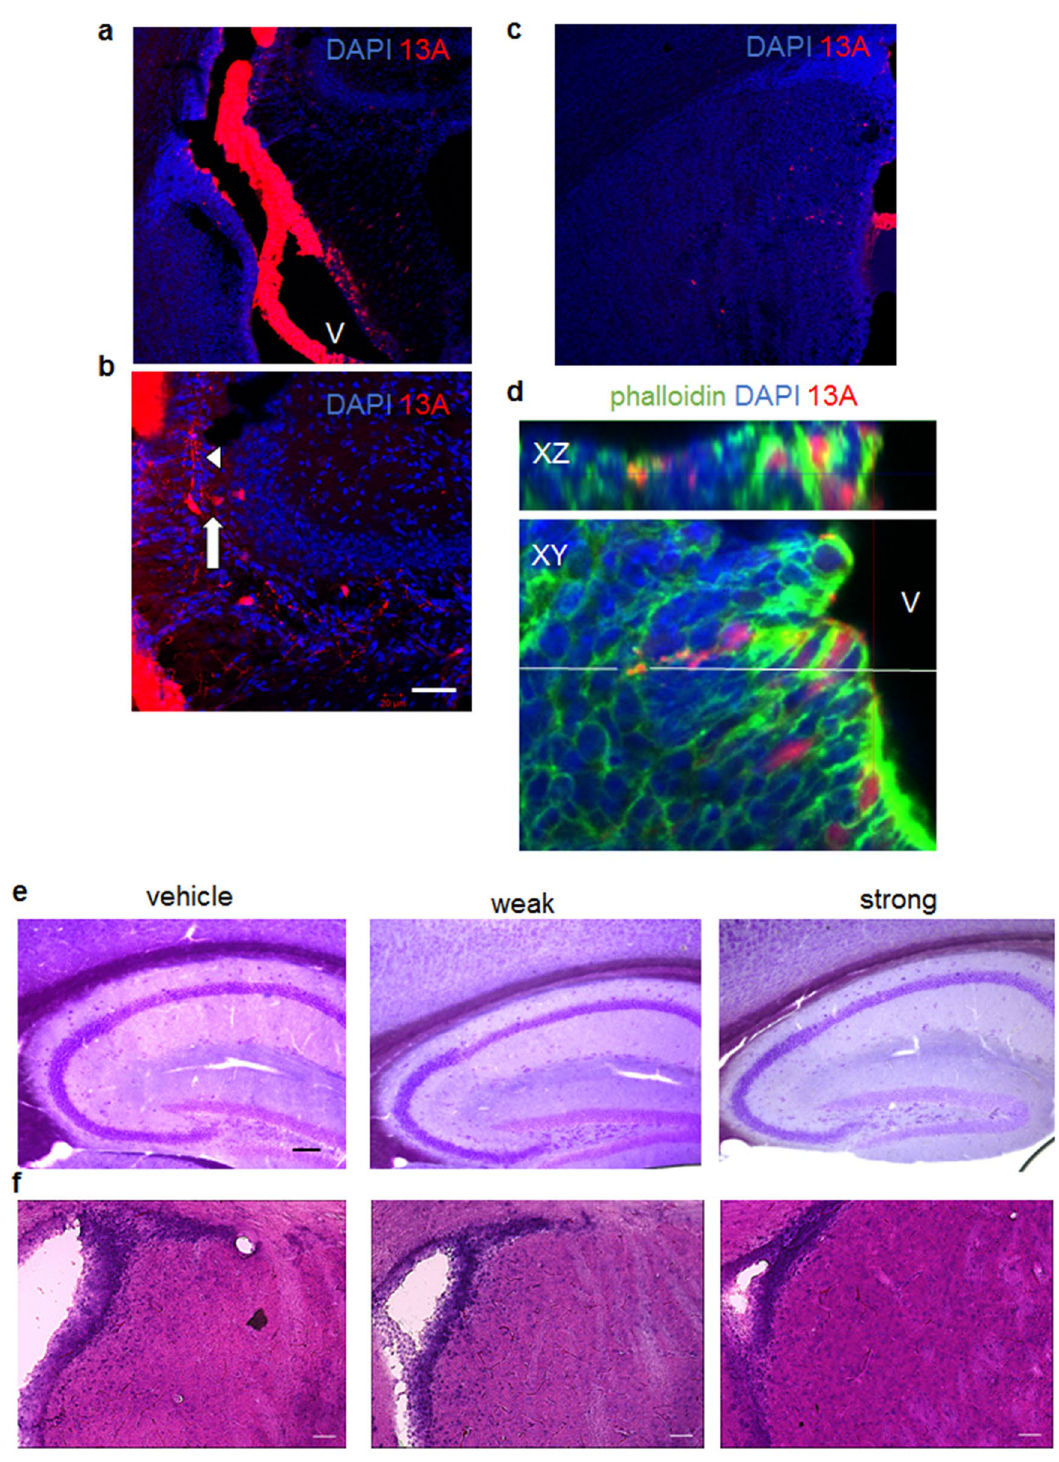
Figure 5. No gloss anatomical changes in mice given 13A at P2. ( a – d ) Fluorescence images of coronal brain sections of mice at postnatal day 2 (P2) one hour after TAMRA-conjugated 13A peptide with strong aggregation (red) was injected into the ventricle. The sections were stained with phalloidin (green) and/or DAPI (blue). The 13A signals are found in the ventricle (V) and also in the brain parenchyma that are close to the ventricle ( a ). The 13A signals in the hippocampus ( b ) and the striatum ( c ) are shown. An ortho XZ-axis cross section confocal image of the brain (top) along the white line on XY-axis view (bottom) was reconstituted from the z-stacks using confocal laser scanning microscopy ( d ). The interval of z-stacks was set at 1 µm. The arrow and arrowhead in ( b ) indicates13A-positive cell bodies and processes, respectively. Scale bar, 50 µm. ( e ) Nissl-stained sagittal sections of the hippocampus from 1-month-old mice treated with vehicle, weak aggregates and strong aggregates. Each representative image was chosen from 14 images. Scale bar, 100 µm. ( f ) HE staining of coronal sections of the striatum from 1-month-old mice treated with vehicle, weak aggregates and strong aggregates. Representative images were chosen from 14, 7, 11 images for vehicle, weak aggregates and strong aggregates, respectively. Scale bars, 50